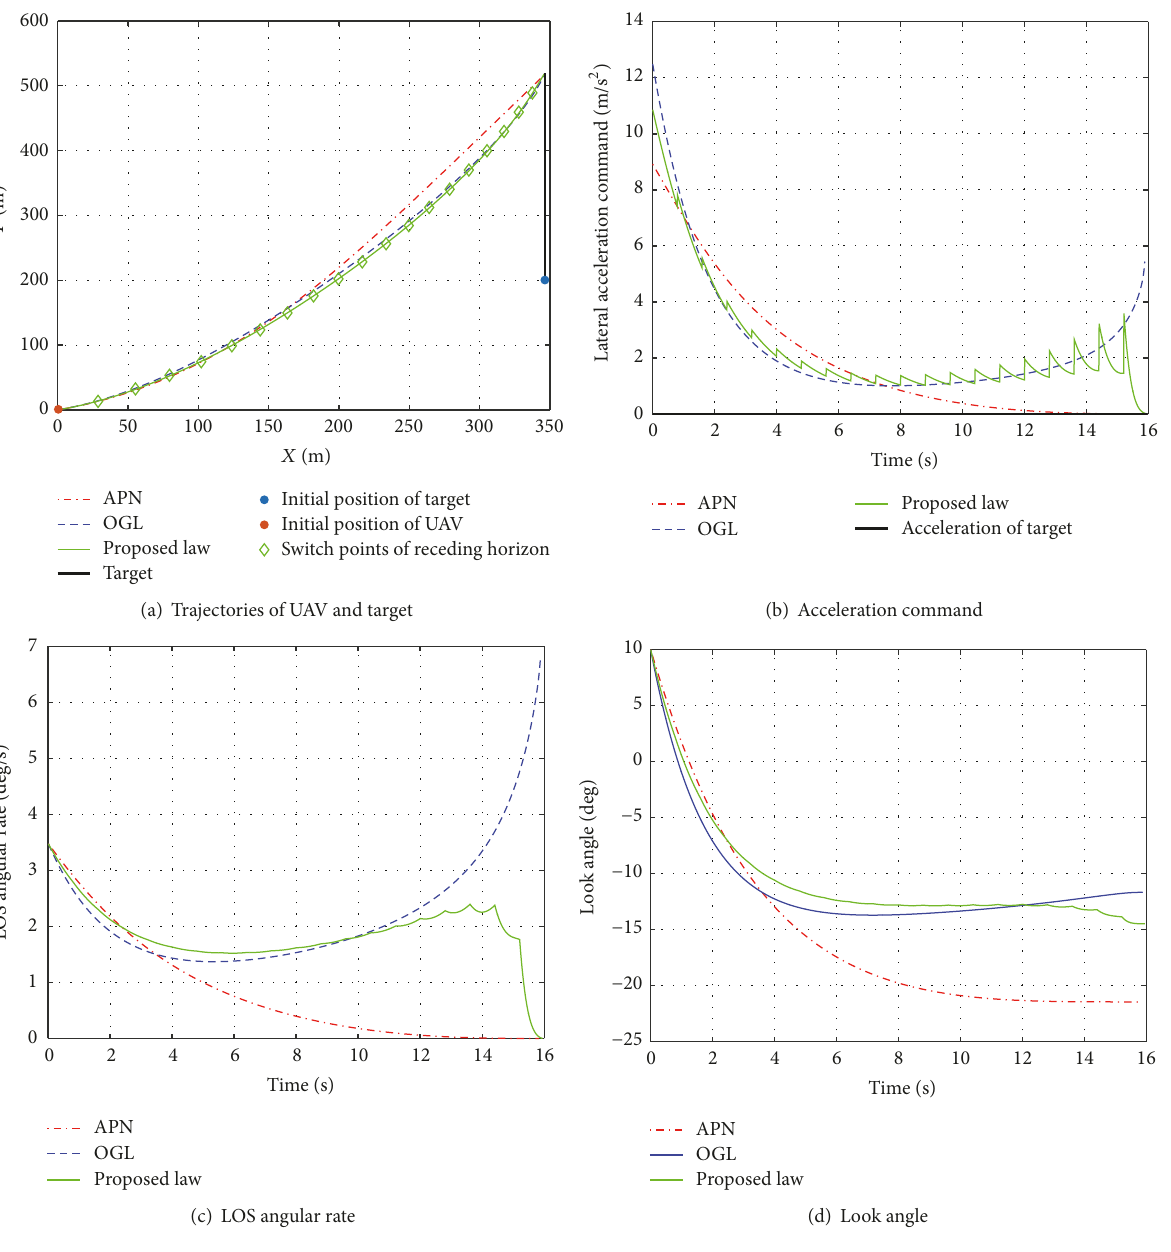
Figure 4: Responses in Case 1 (𝑎 𝑇 = 0 m / s 2 , 𝜃 𝑀0 = 90 ∘ )